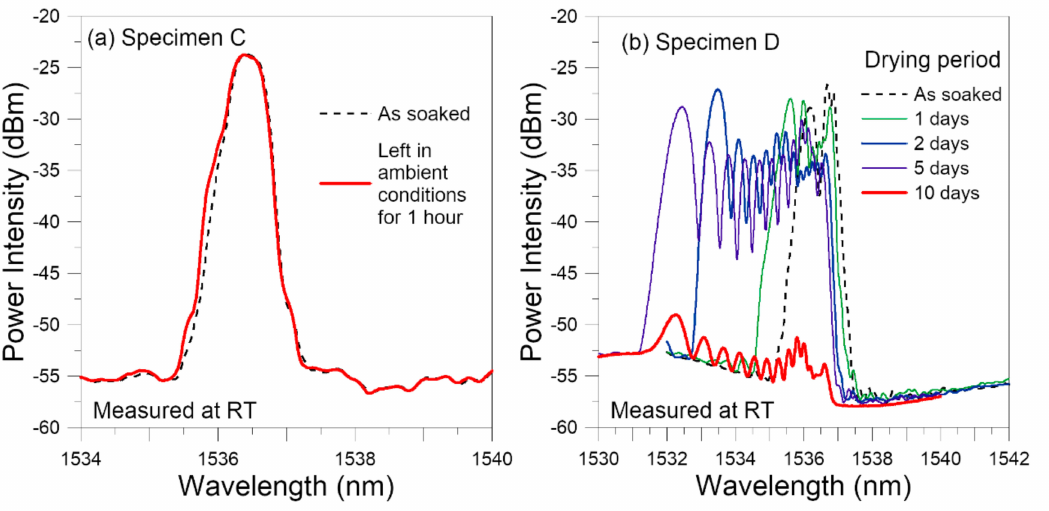
Figure 14. Evolution of FBG spectra from the two fatigue specimens during drying in: ( a ) ambient condition for 1 h; ( b ) in a desiccator for 10 days.